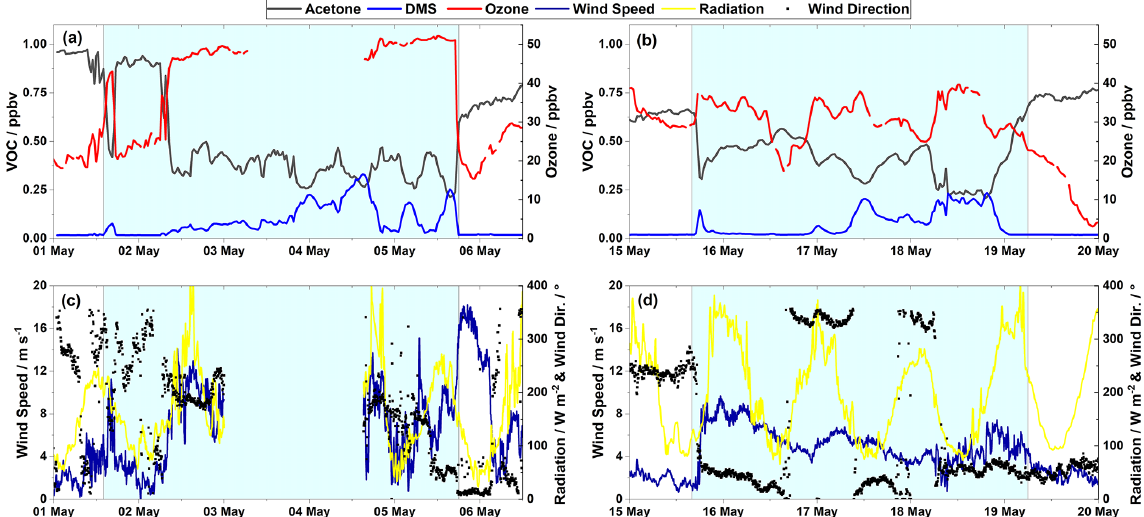
Figure 3. (a,c) The first period of elevated DMS mixing ratios (1–5 May). (b,d) The second period of elevated DMS mixing ratios (15– 19 May). Panels (a) and (b) show the mixing ratios of acetone and DMS (left axis), and ozone (right axis); panels (c) and (d) show the wind speed (left axis) and radiation and wind direction (right axis). The shaded area represents episodes of elevated DMS mixing